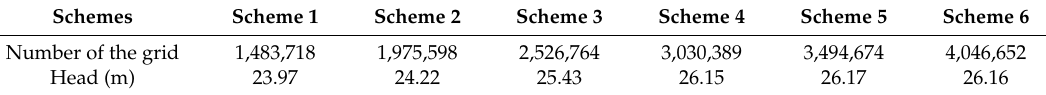
Table 2. The grid independence analyzation.